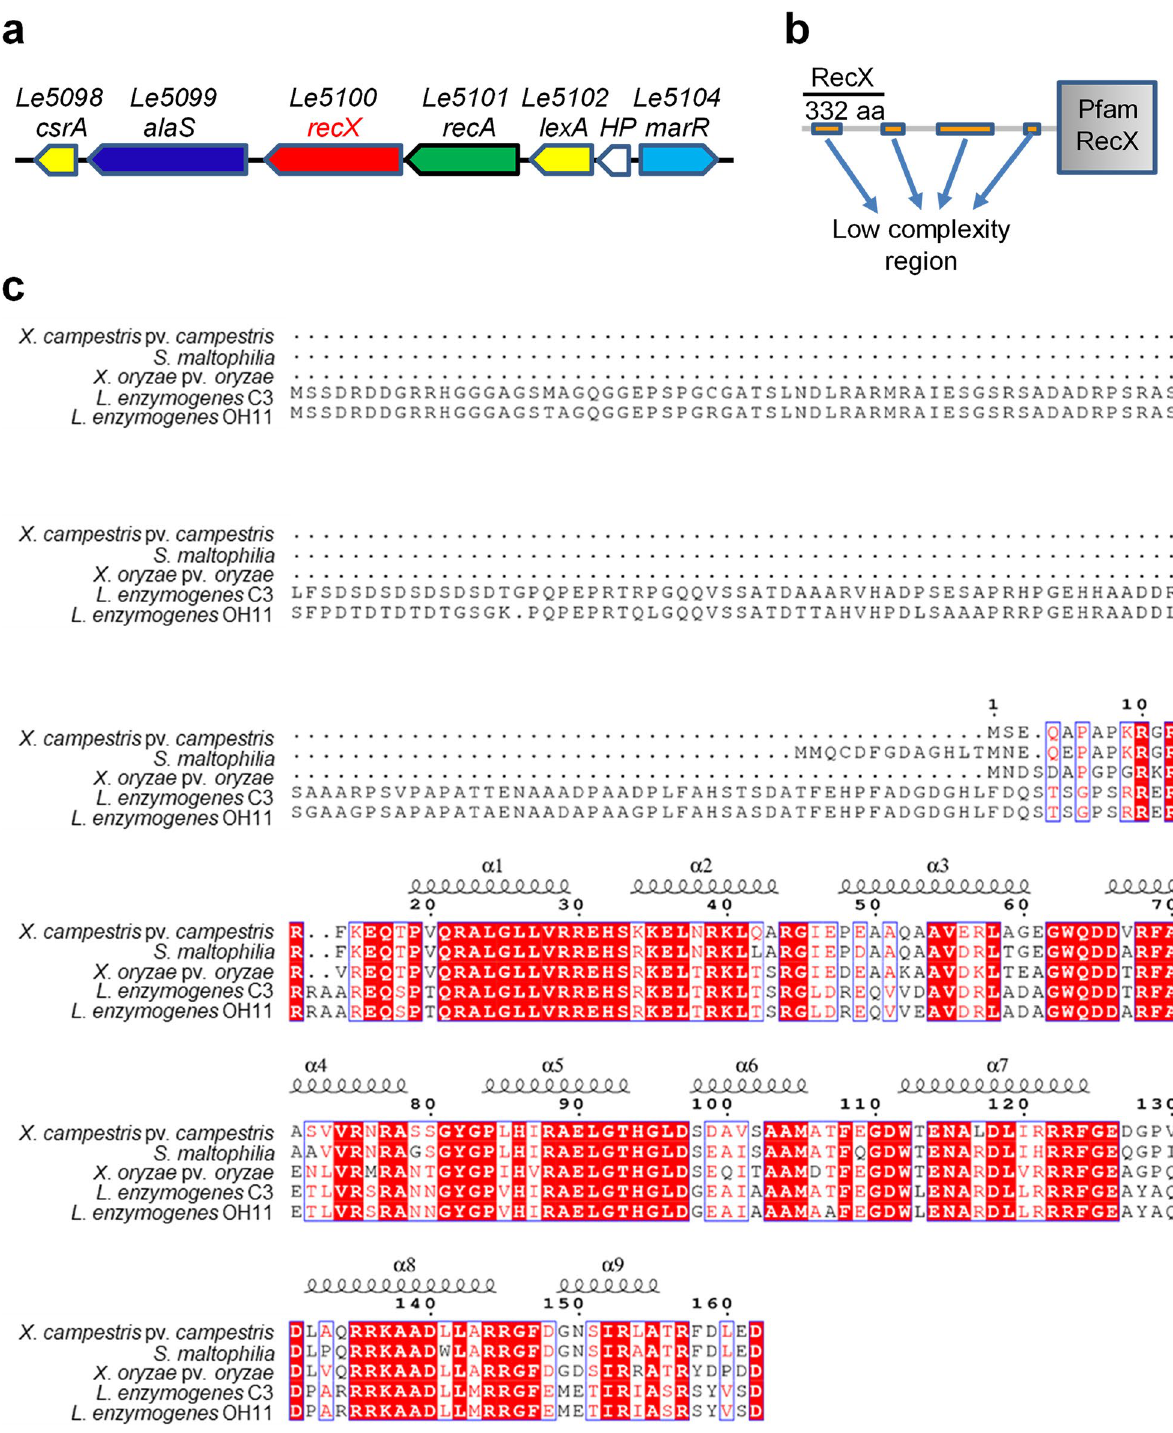
Fig. 3 Identification and sequence characterization of RecX in Lysobacter enzymogenes . a Genomic localization of recX . csrA : carbon storage regulator; alaS : alanyl-tRNA synthetase; recX : regulatory protein; recA : recombination protein; lexA : repressor LexA; HP : hypothetical protein; marR : MarR family N-acetyltransferase transcriptional regulator; cinA : competence damage-inducible protein A. b Bioinformatics analyses of the domain organization of RecX. c Alignment of L. enzymogenes , Xanthomonas campestris pv. campestris , X. oryzae pv. Oryzae , and Stenotrophomonas maltophilia RecX sequences. The alignment was performed with Clustal W based on identical